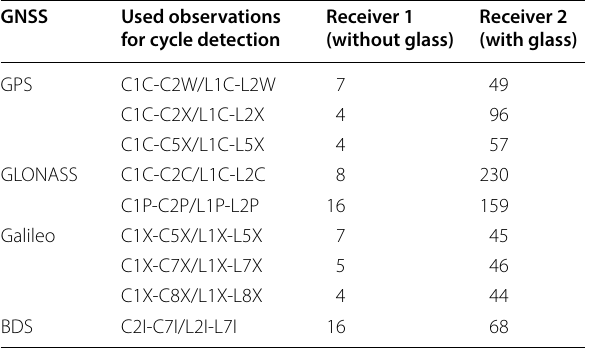
Table 3 Cycle slip statistics for GPS, GLONASS, Galileo, and BDS signals tracked by the two GNSS receivers in the experiment during period 1